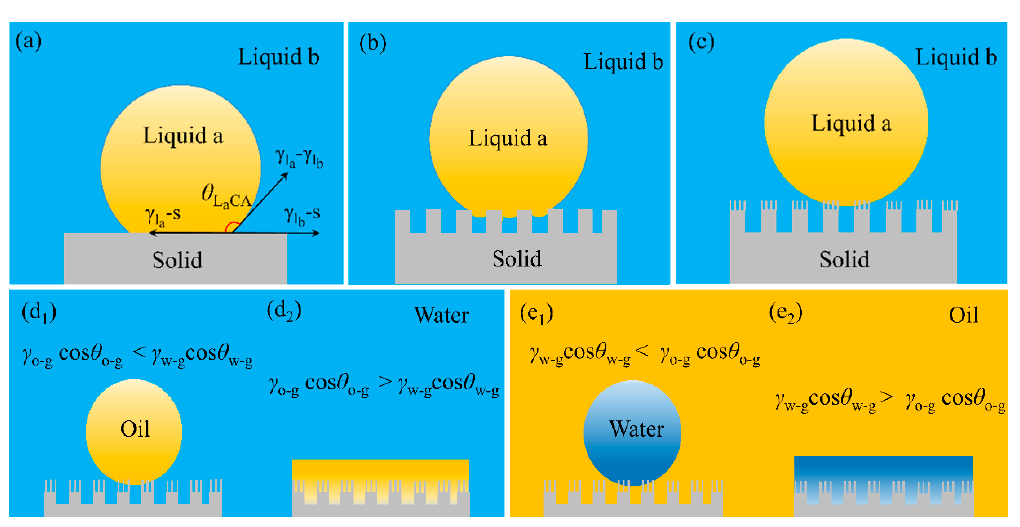
Figure 6. ( a – c ) Illustration of the behavior wetting effect by surface structure of the solid substrates in oil/water [30]. ( a ) smooth surface, ( b ) microstructure surface, ( c ) micro/nanohierarchical surface in liquid b; reproduced with permission from Wiley. ( d , e ) Illustration of the theoretical extreme wettability of solid substrate surface in water/oil [87]. The substrate exposed in the water or oil shows four oil–water states: ( d 1 ) superoleophobic, ( d 2 ) superoleophilic, ( e 1 ) superhydrophobic, ( e 2 ) superhydrophilic. o ‐ g: oil and gas interface, w ‐ g: water and gas interface; reproduced with permission from American Chemical Society.